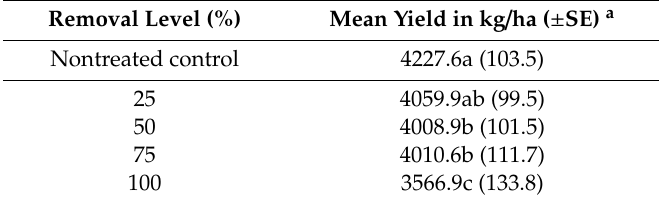
Table 4. E ff ect of the fruit removal level on soybean yield during the 2016 and 2017